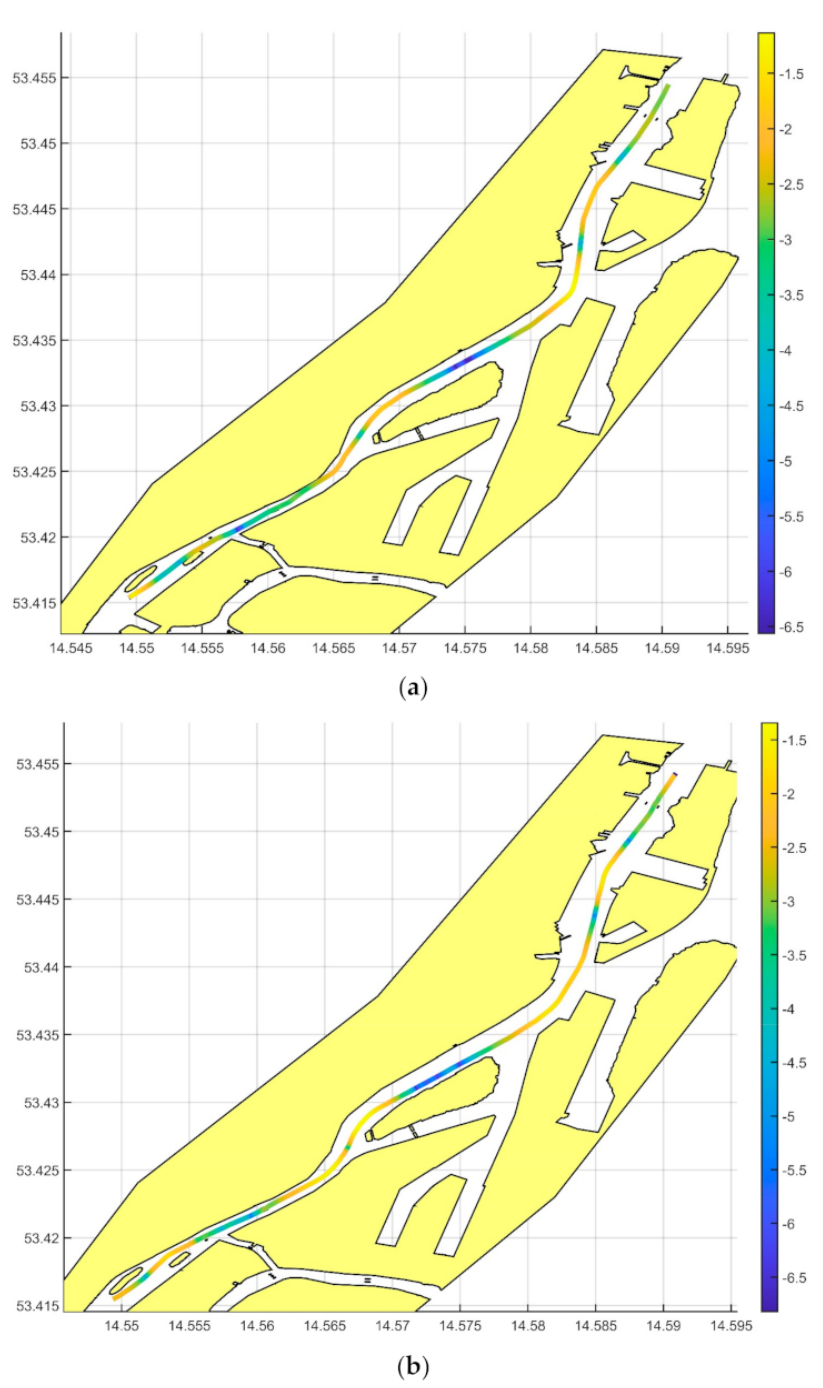
Figure 5. Impact of the curvature of the measurement profile on the recorded gravimetric signal. The spatial distribution of the correction is shown on the maps for the first line ( a ) and for the second line ( b ); a logarithmic scale is